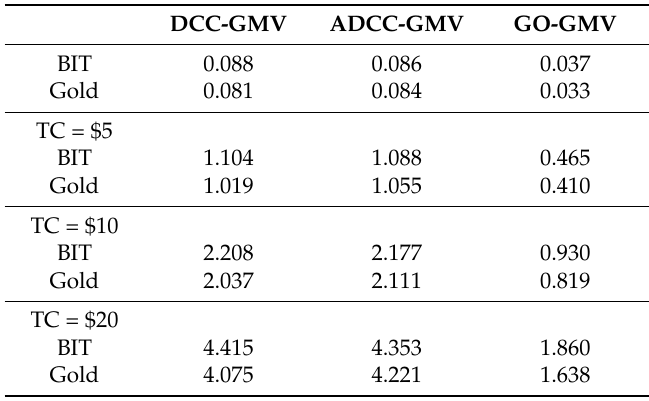
Table 10. Turnover and trading costs: Long